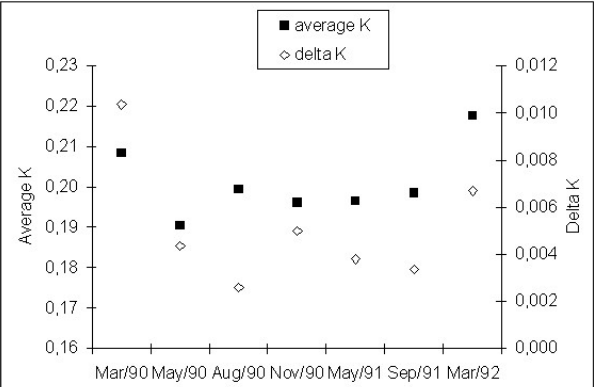
Fig. 5 . Analyses of the sex ratio of C. spilopterus : a) by length groups and b) by